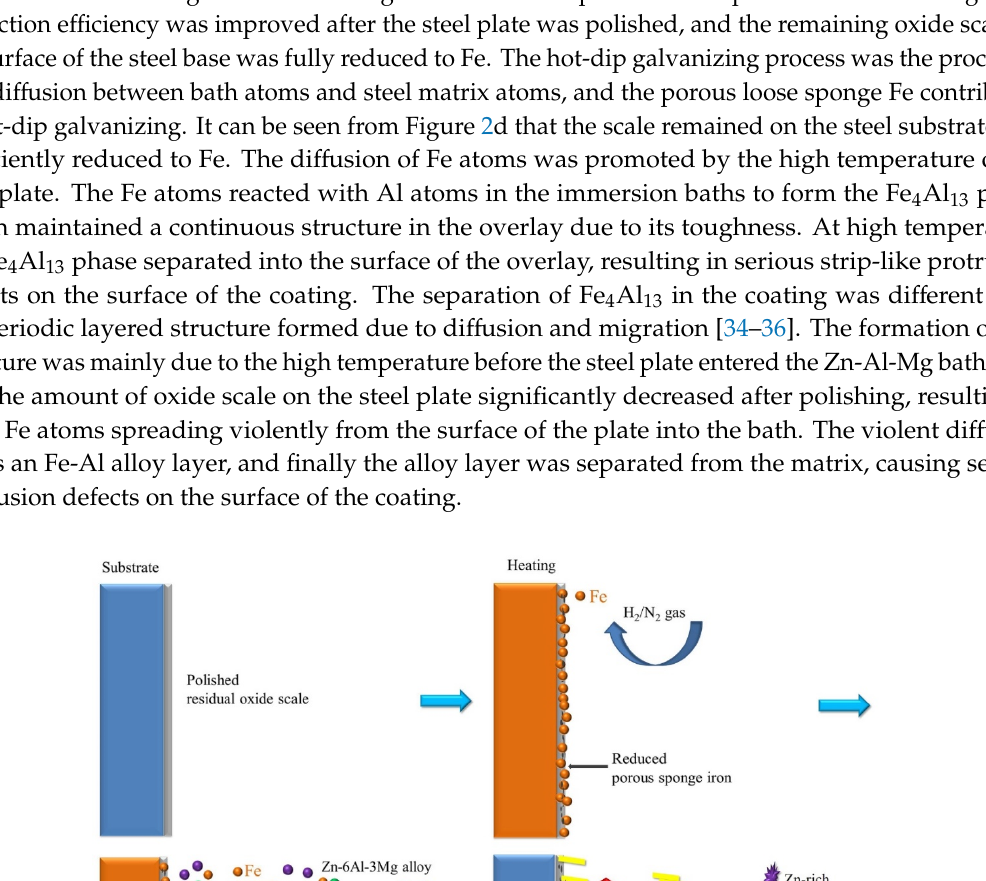
Figure 13. Element distribution of cross section of coating of polished steel plate. ( a ) The cross-